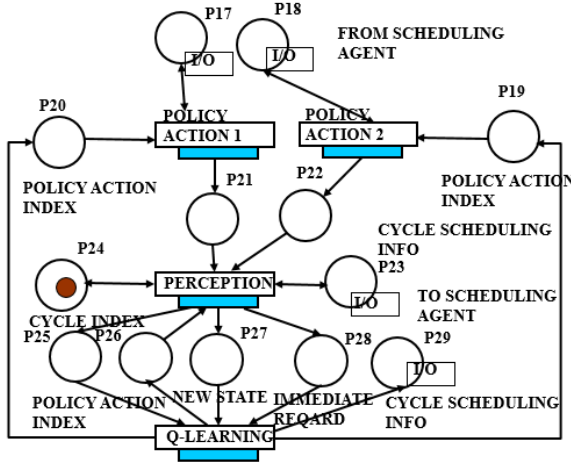
Figure 4. The implemented hierarchical CTPN model of the Order Sequencing substitution transition.